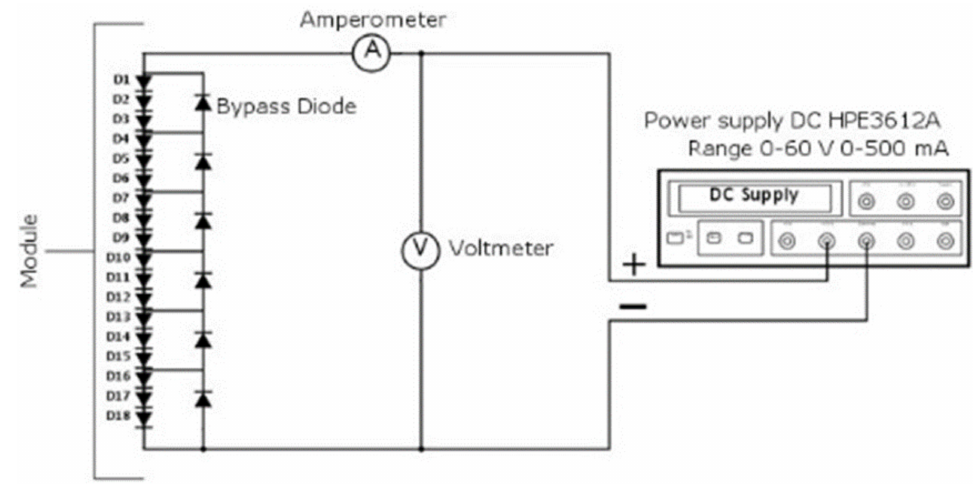
Figure 3. Diagram of the test circuit.